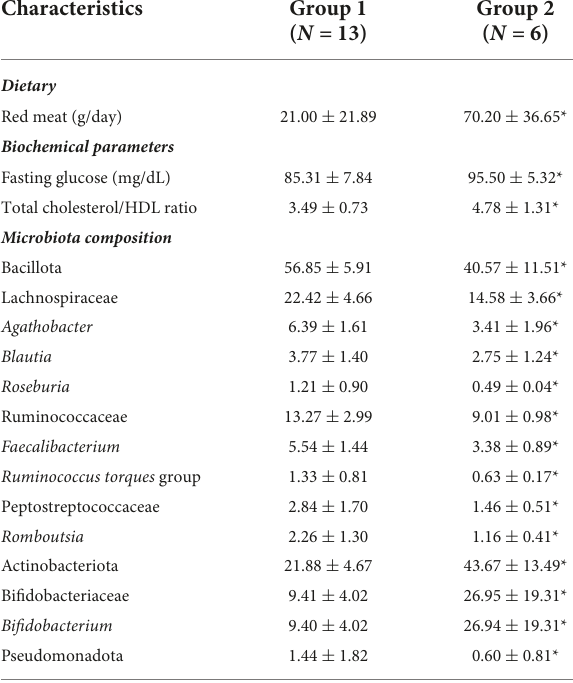
TABLE 4 Dietary and microbiota differences according to microbiota profile distribution of main phyla in the sample of study.